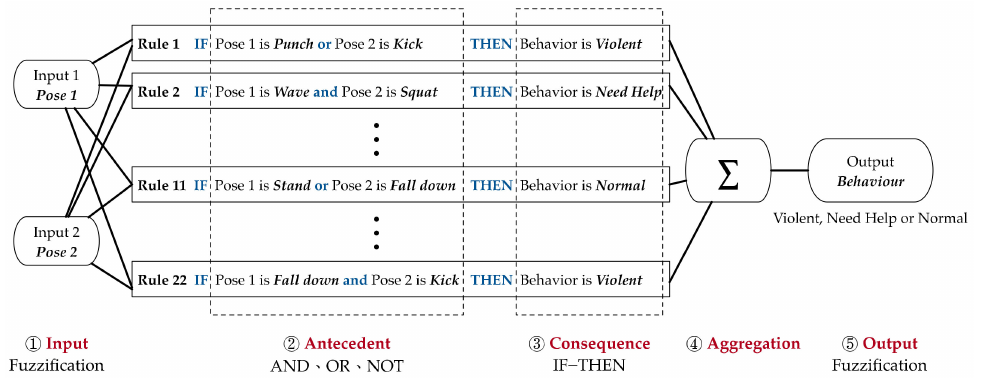
Figure 11. The fuzzy inference processes.